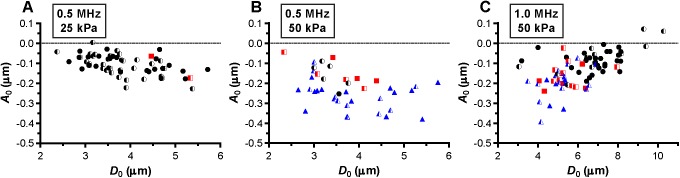
The maximum negative amplitude of A0.For microbubbles insonified at a frequency of 0.5 MHz and P_ of 25 kPa (A), frequency of 0.5 MHz and P_ of 50 kPa (B), and frequency of 1 MHz and P_ of 50 kPa (C). For figure legend, see the rightmost column of Fig 2 and Fig 3.